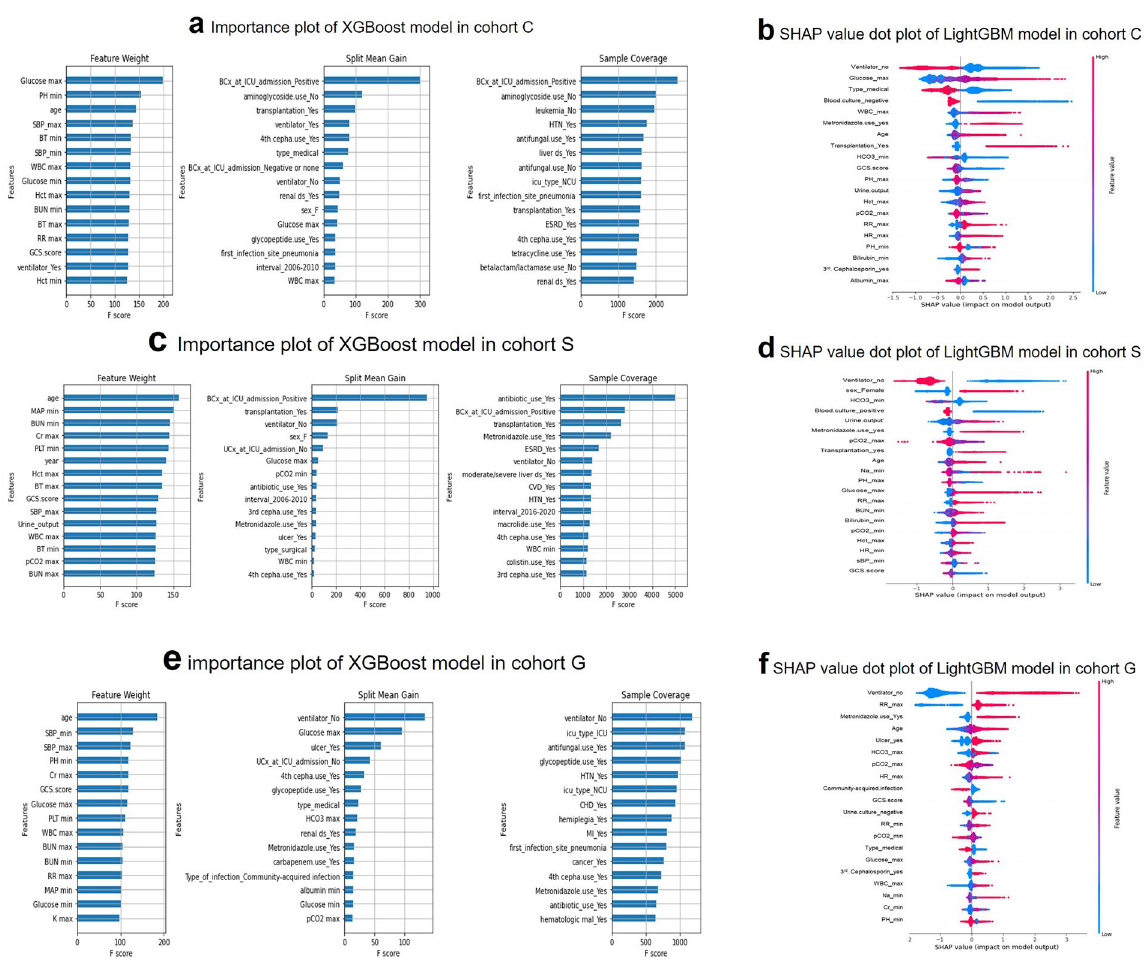
Figure 3. Critical variables with feature importance plots and SHAP values for predicting in-hospital mortality. XGBoost extreme gradient boost, LightGBM light gradient boosting machine, SHAP Shapley additive explanation. ( a ) Feature importance including feature weight, mean gain and coverage of XGBoost and ( b ) SHAP value summary dot plot of the LightGBM-based prediction model in cohort C. ( c ) Feature importance including feature weight, mean gain and coverage of XGBoost and ( d ) SHAP value summary dot plot of the LightGBM- based prediction model in cohort S. ( e ) Feature importance including feature weight, mean gain and coverage of XGBoost and ( f ) SHAP value summary dot plot of the LightGBM-based prediction model in cohort G. The color of the SHAP dot represents the value of the feature, and the location of the dot on the X axis represents its SHAP value. Red dots indicate higher values or affirmative responses (for binary features), and blue dots indicate the opposite. A positive SHAP value indicates that the variables increase the likelihood of in-hospital